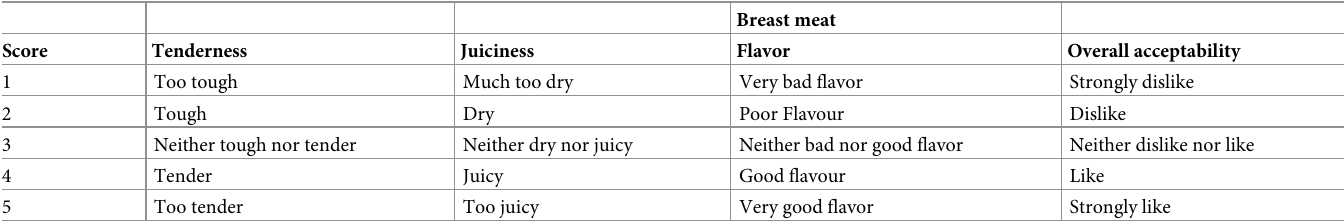
Table 3. Evaluation score used by the sensory panel.